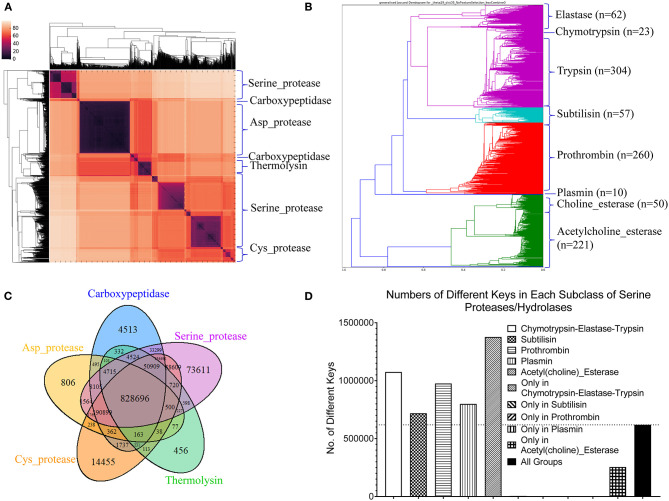
The clustering of proteases by our TSR-based structural comparison method. (A) The heatmap shows the cluster of proteases. The dissimilarity values are indicated in the upper left corner in all clustering heatmaps. The PDB IDs, and chain and class information can be found in Supplementary File 1. The complete list of the clustering result in the same order as the clustering map are provided in Supplementary File 1A; (B) The Venn diagram shows counts of the keys that are specific to each class of proteases, and all possibly overlapped regions among protease classes; (C) The dendrogram shows the clustering of the serine proteases. Number of the proteins in each subclass is indicated; (D) Total numbers of the keys and numbers of the specific keys to each class of serine proteases were calculated. Number of the common keys belonging to all classes of serine proteases were calculated. b and d, Key frequencies are not included for calculating the number of the keys corresponding to each class of proteases (B), and each subclass of serine proteases (D). Total distinct keys of a class were calculated from all the proteins in that class. These specific calculations are applied for (sub)classes of kinases and phosphatases. We designate the common keys at (sub)class levels.